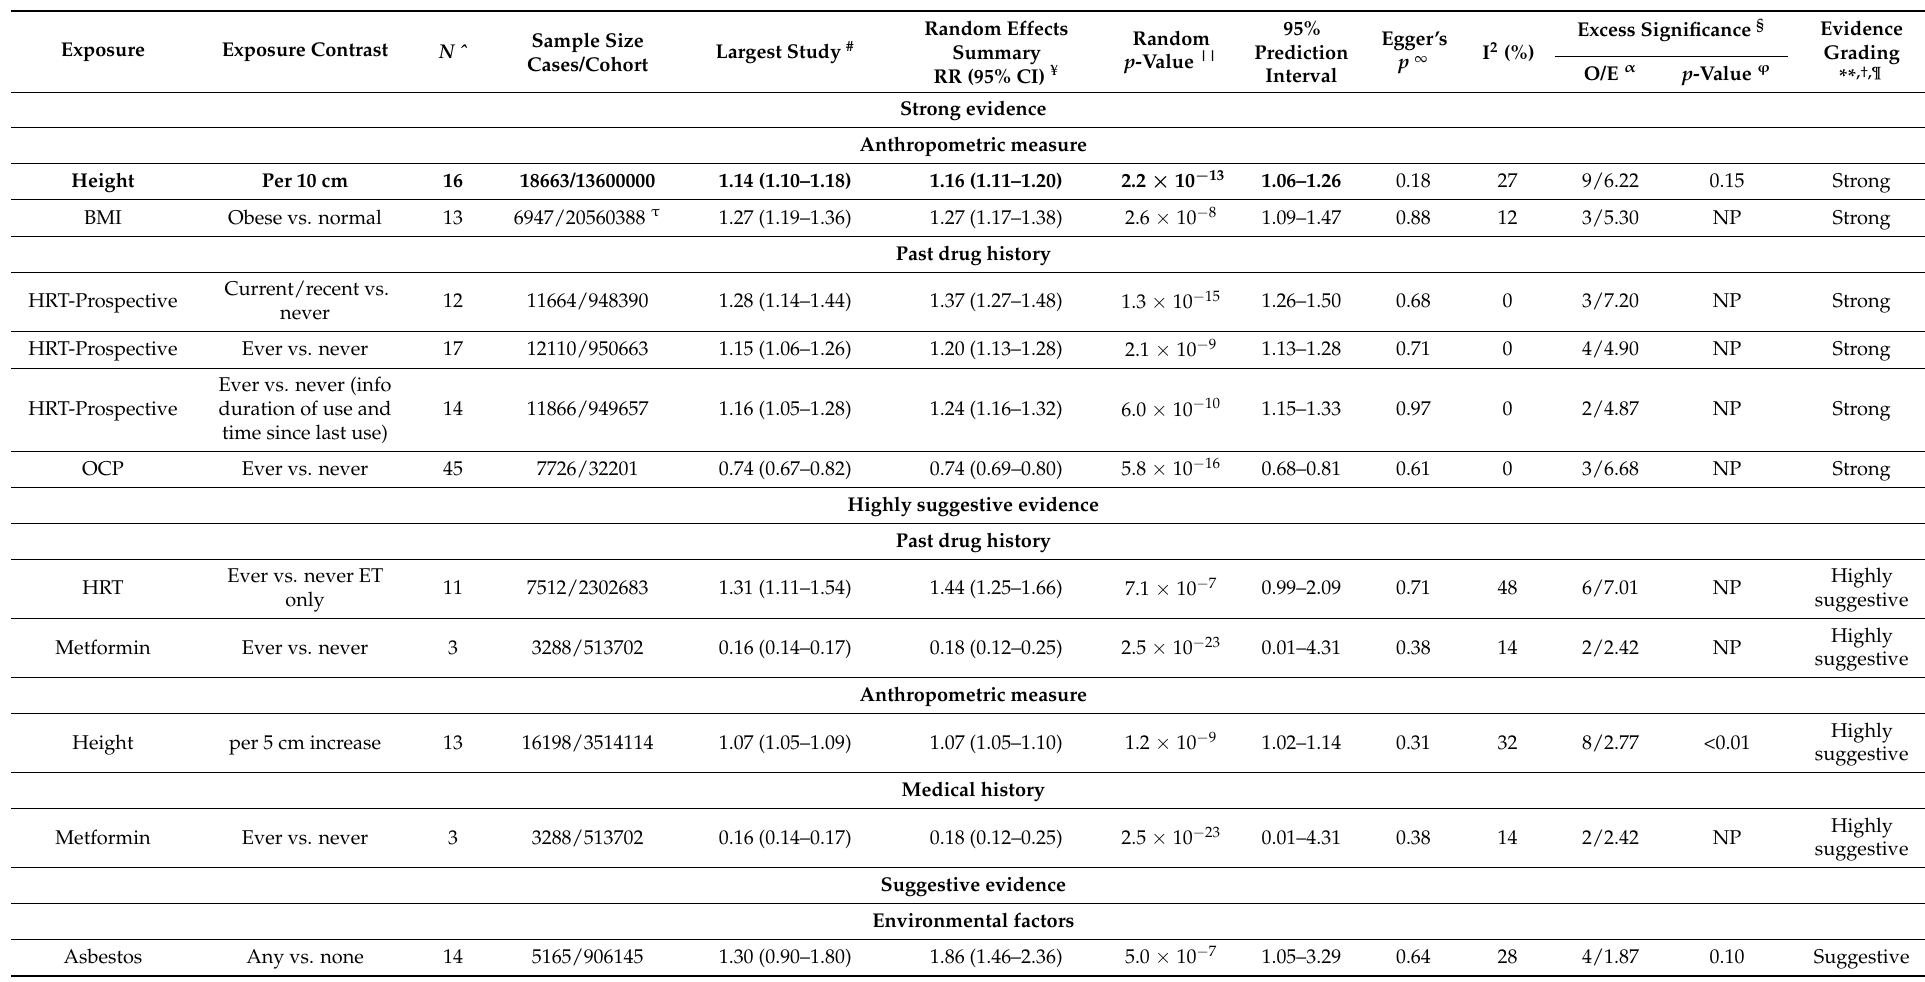
Table 2. Details of evidence grading for meta-analysis of risk factors for ovarian cancer incidence or mortality—only cohort studies included